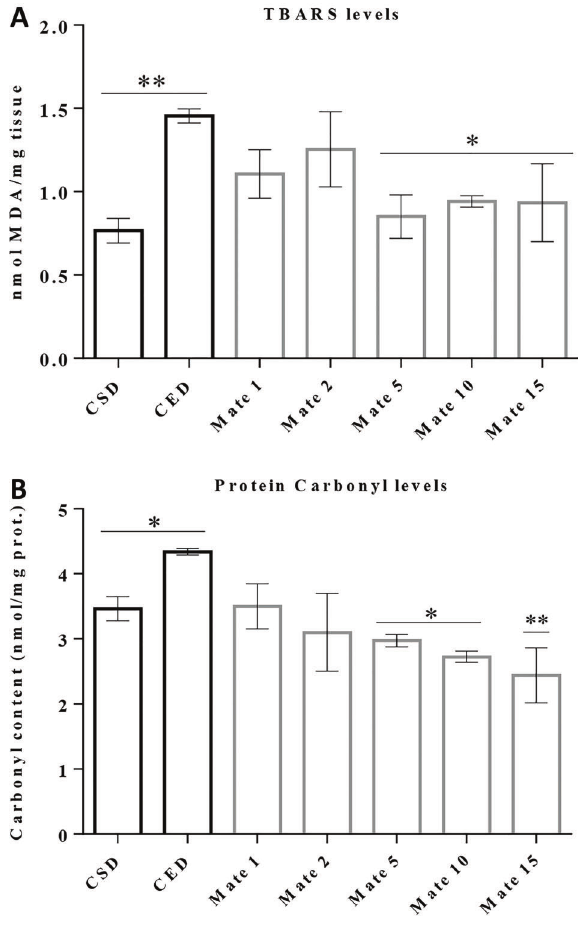
Figure 8. TBARS and carbonyl protein levels. Flies were homo- genized in groups of 50 males after 10 days on various diets: control standard diet (CSD), control experimental diet (CED) and experimental diet + mates (Mate 1 to Mate 15). Data are reported as means ± SE for n=3. *P o 0.05, **P o 0.01, ANOVA followed by Dunnett ’ s